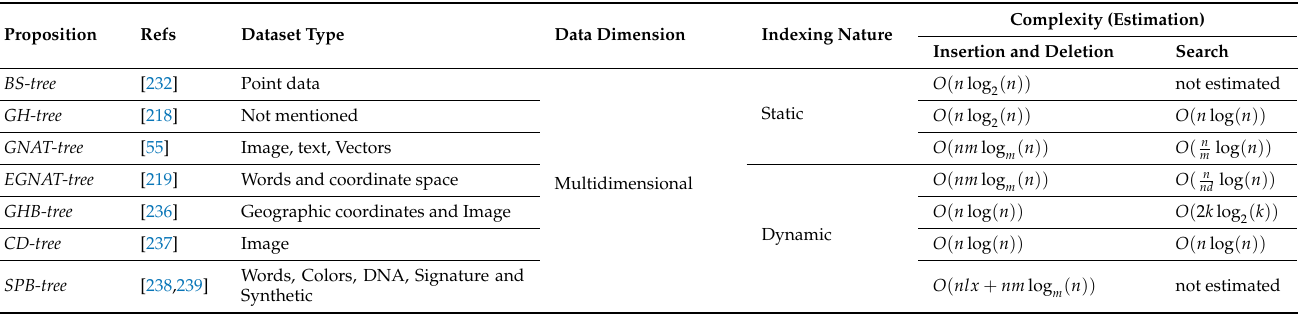
Table 13. Analysis of metric indexing techniques based on hyper-plane partitioning.